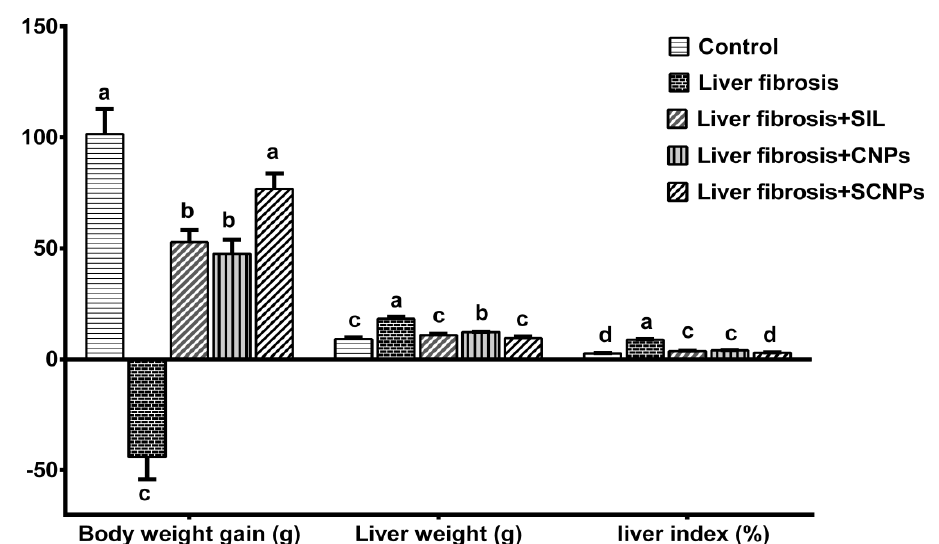
Figure 5. Effect of different groups on body weight gain, liver weight, and liver index (%). Data are presented as mean ± SD ( n = 6). The means of the groups in the same column with the same superscript letter are not significantly different, while the means with different letters are significantly differed according to the ANOVA test, followed by the post hoc test (Tukey). At p ≤ 0.05, the difference was statistically significant.